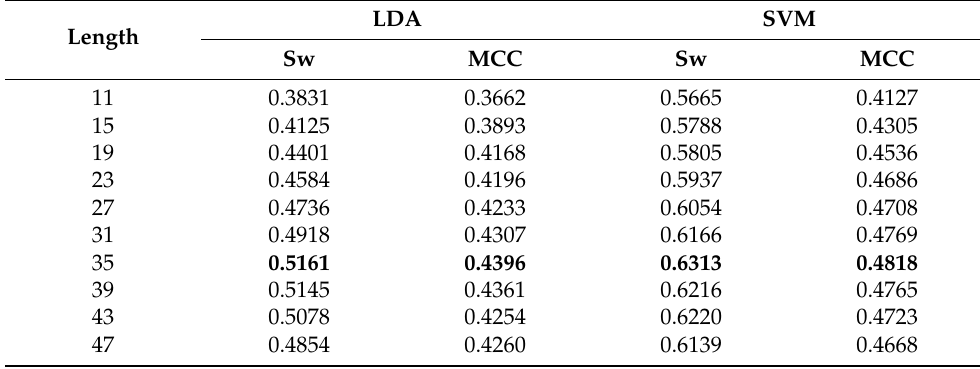
Table 5. Prediction performance of different window lengths in LDA/SVM.